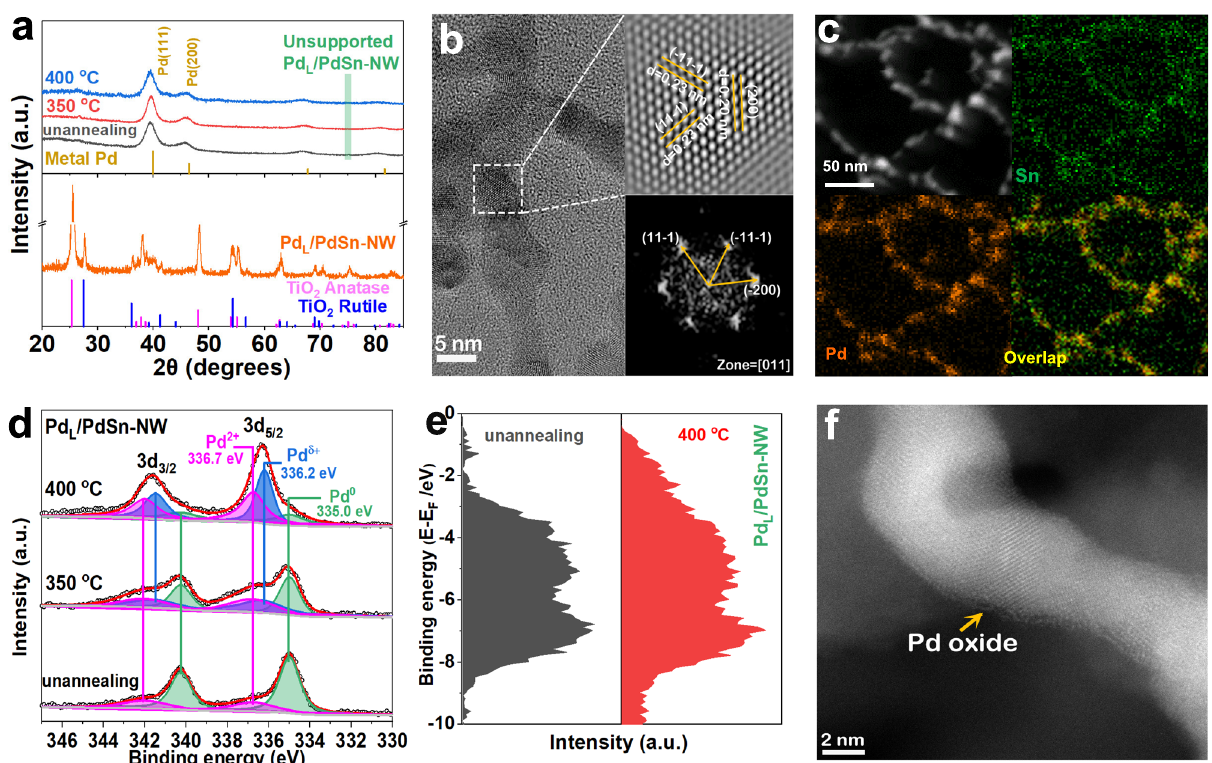
Fig. 3 | Structural characterization of the unsupported and supported Pd L / PdSn-NWcatalystsbeforeandafterannealinginairat400°C.a XRDpatternsof the unsupported andsupported Pd L /PdSn-NWcatalysts beforeand afterannealing inair. b HRTEMimageoftheunsupportedPd L /PdSn-NWsampleshowingthelattice fringesof thePdSnphase. c STEMimage and STEM-EDSmappingof thesupported Pd L /PdSn-NW showing the close proximity of both Pd and Sn elements,